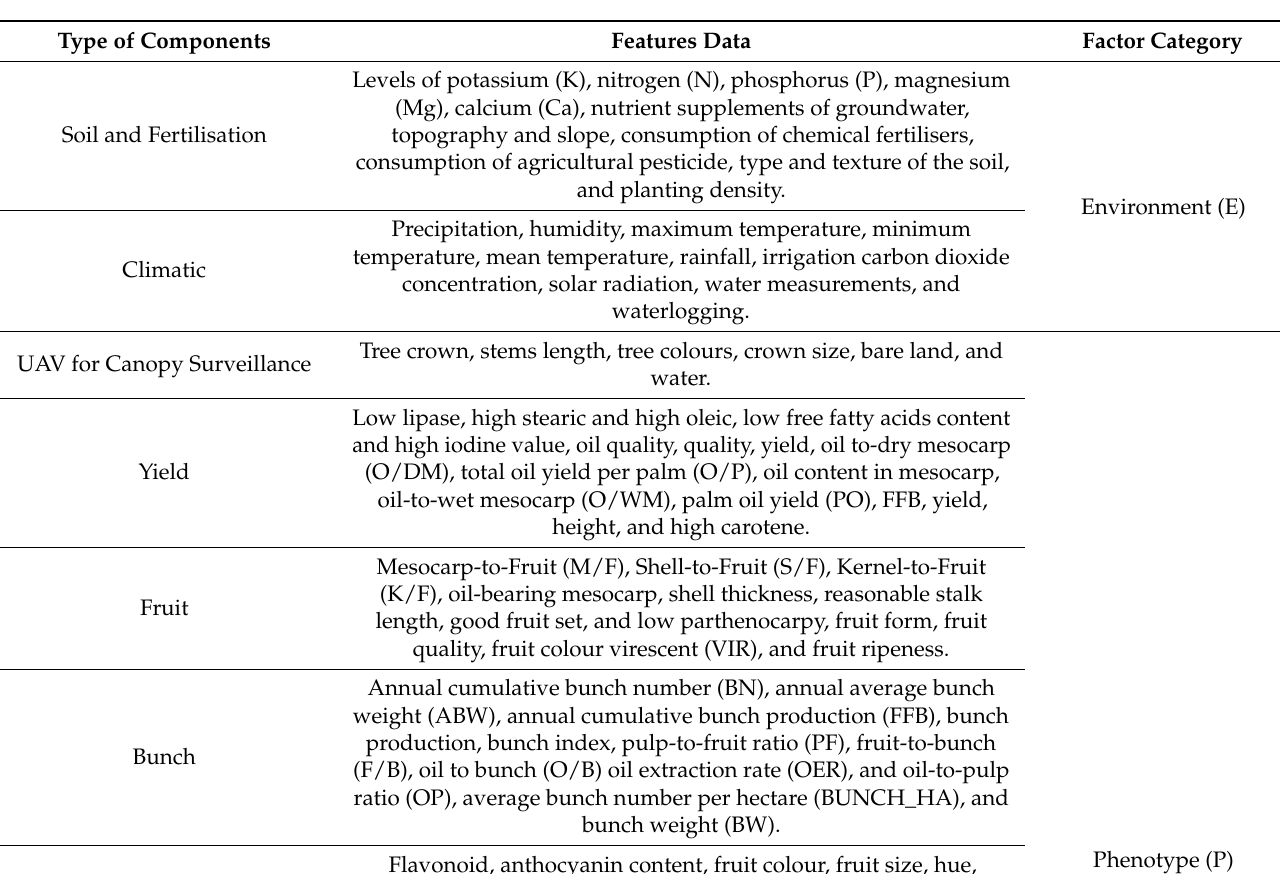
Table 2. Categorical